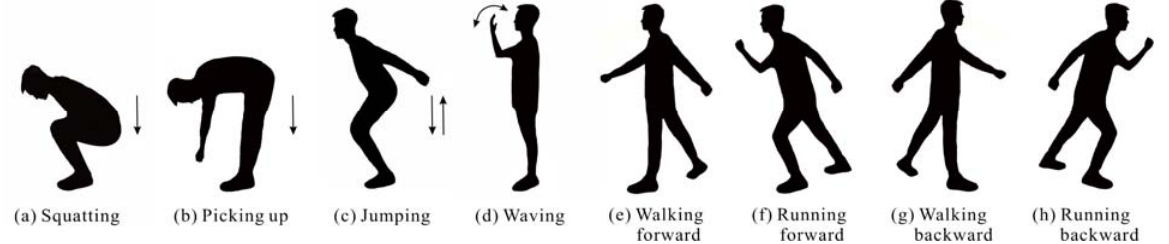
Figure 8. Geometries of the intruder’s eight